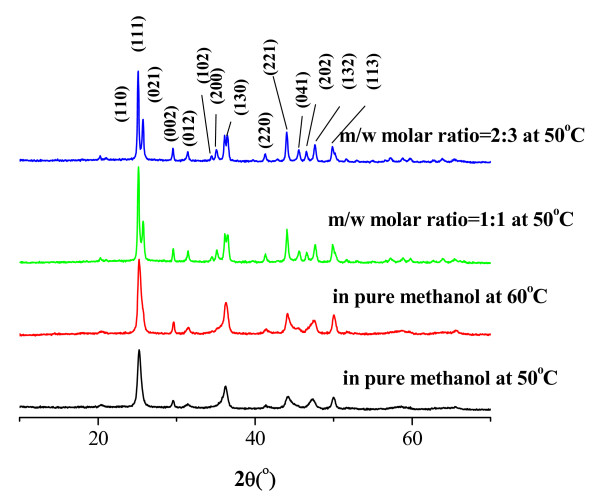
XRD pattern of as-synthesized SrCO3.